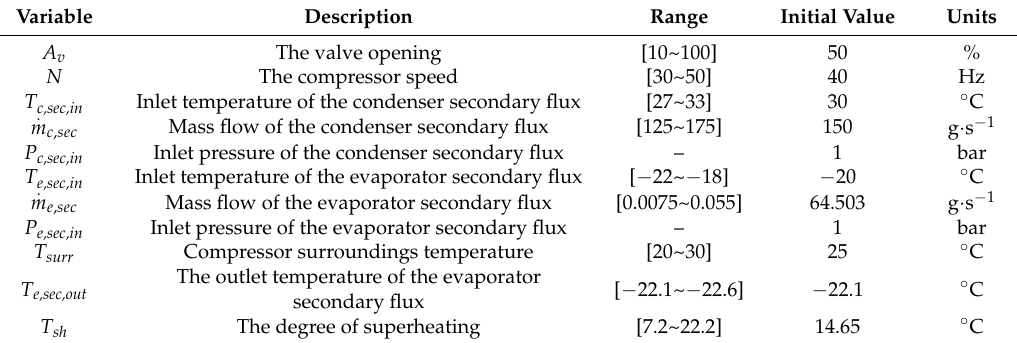
Table 1. Variables in the refrigeration